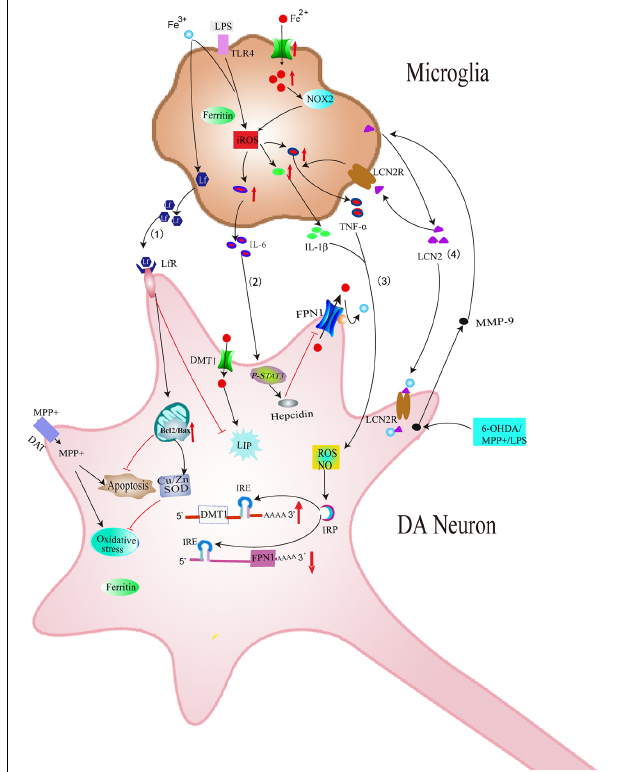
FIGURE 3 | Schematic illustration showing several effects of microglia on iron metabolism and degeneration of DA neurons in PD. (1) Iron overload-induced activation of microglia increases the release of Lf, which provides neuroprotection against MPP + in DA neurons. (2) LPS could induce the release of IL-6 in microglia, which could increase the expression of hepcidin in DA neurons, thus inhibiting FPN1-mediated iron efflux in DA neurons. (3) Excessive activation of microglia induced by LPS or neurotoxins could release IL-1 β and TNF- α , which aggravates iron accumulation of DA neurons by up-regulating DMT1+IRE and down-regulating FPN1. (4) MMP-9 released by damaged DA neurons could lead to upregulation and release of LCN2. LCN2 then activates microglia to release TNF- α and IL-1 β , which is involved in the abnormal expression of DMT1 and FPN1 in DA neurons. LCN2 released from activated microglia might also induce direct neurotoxicity via excessive iron delivery into DA neurons by binding to LCN2